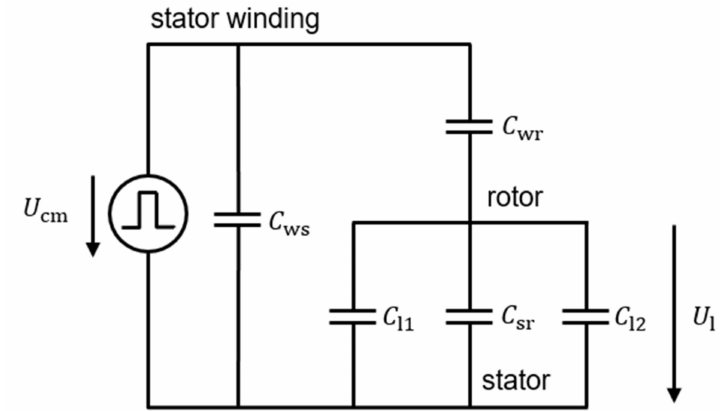
Figure 1. High-frequency capacitive equivalent circuit diagram of an electrical machine [3].